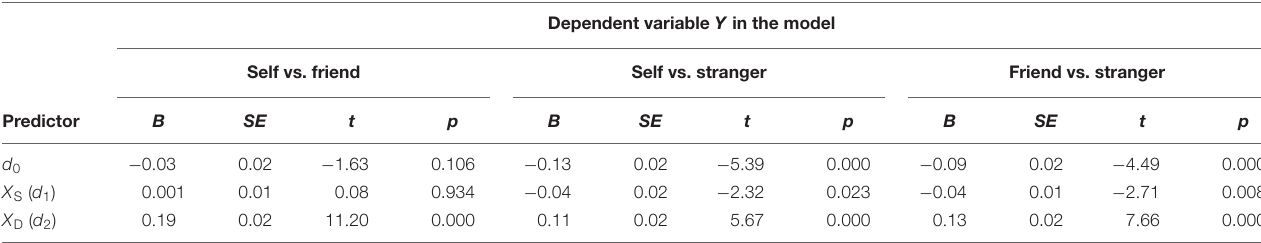
TABLE 1 | Loss aversion mediated the effect of social distance on risk rate difference between loss and gain situations. Dependent variable Y in the